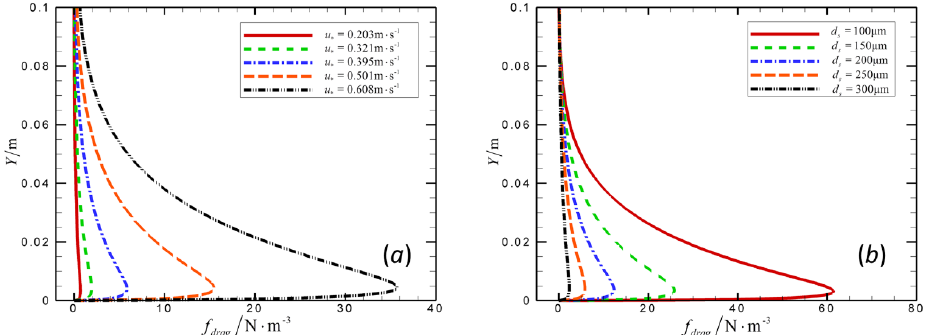
Figure 6. Variation with height of the drag density. ( a ) The profile varies with friction velocity ( d s = 250 µ m). ( b ) The profile varies with particle size ( u ∗ = 0.395 m / s).